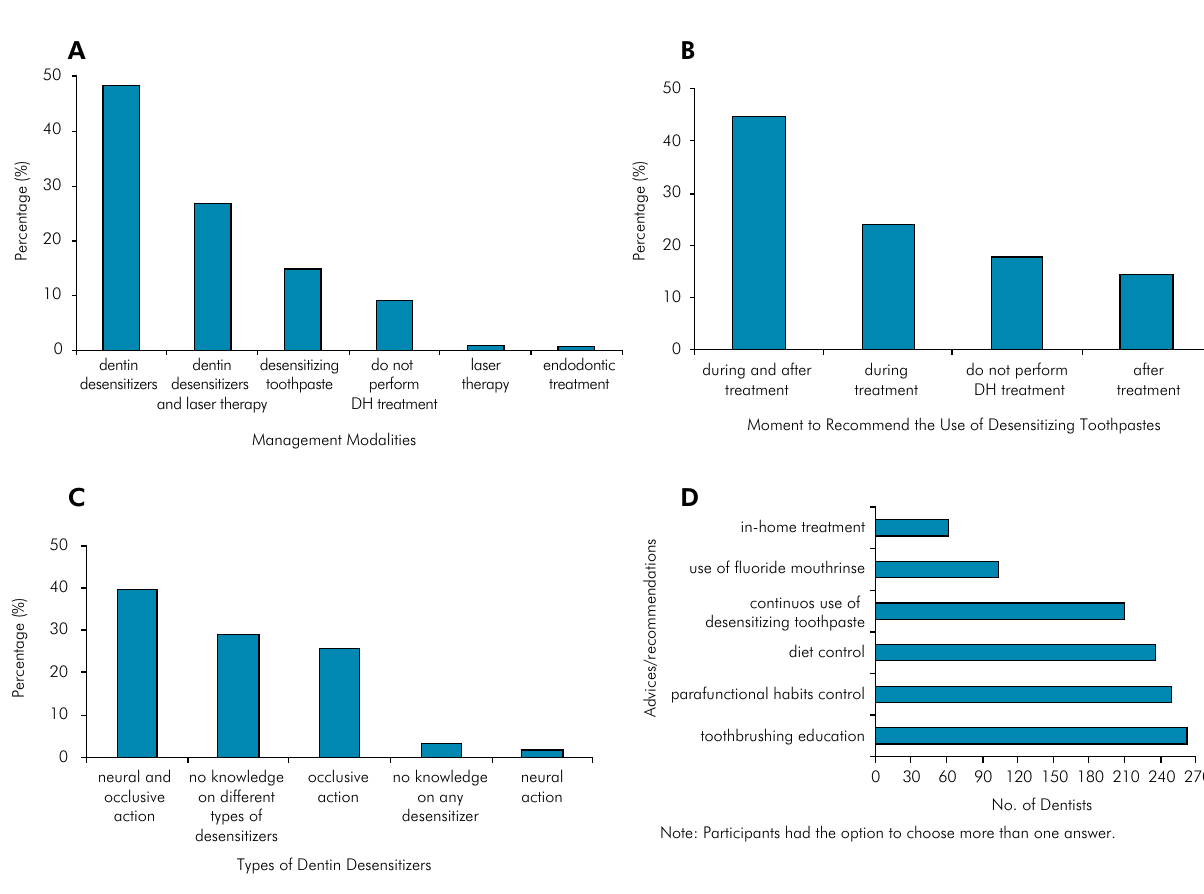
Figure 2. A. Management modalities used routinely when treating DH. B. When to recommend desensitizing toothpastes. C. Types of dentin desensitizers known by the respondents. D. Advice/recommendations offered to patients during DH management, according to dentists